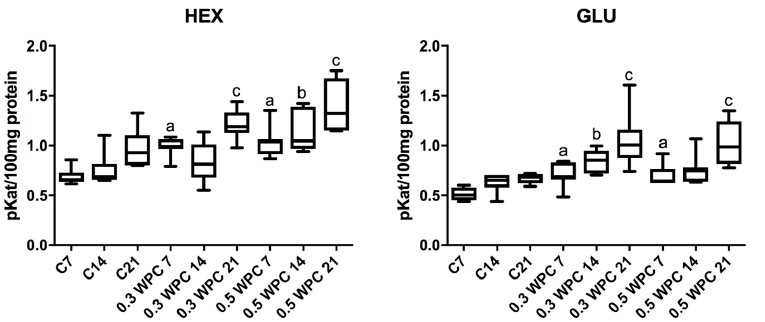
Figure 3. Activity of N-acetyl- β -D-hexosaminidase (HEX) and β -glucuronidase (GLU) in the liver of WPC-80-fed rats and the controls. C7, C14, C21, control groups; 0.3 WPC 7, 0.3 WPC 14, 0.3 WPC 21, 0.5 WPC 7, 0.5 WPC 14, 0.5 WPC 21, experimental groups. Differences statistically important: a vs C7; b vs C14; c vs C21 ( p < 0.05).